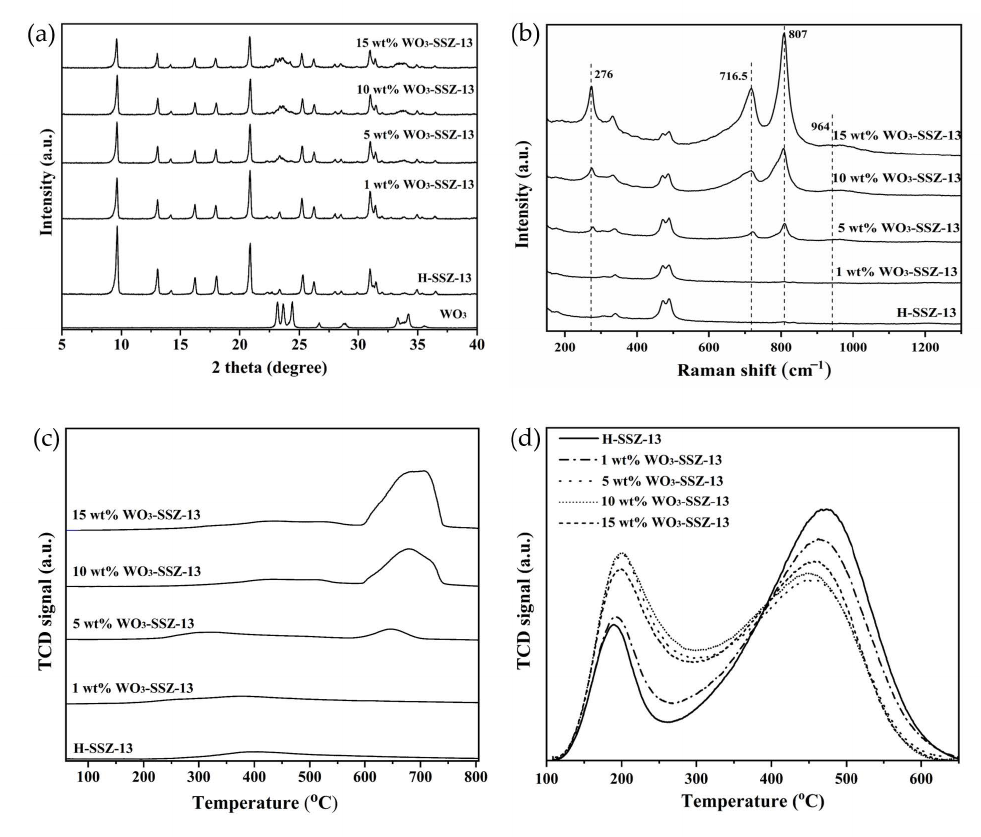
Figure 1. ( a ) PXRD patterns, ( b ) Raman spectra, ( c ) H 2 -TPR profiles, and ( d ) NH 3 -TPD profiles of the H-SSZ-13 and WO 3 -SSZ-13